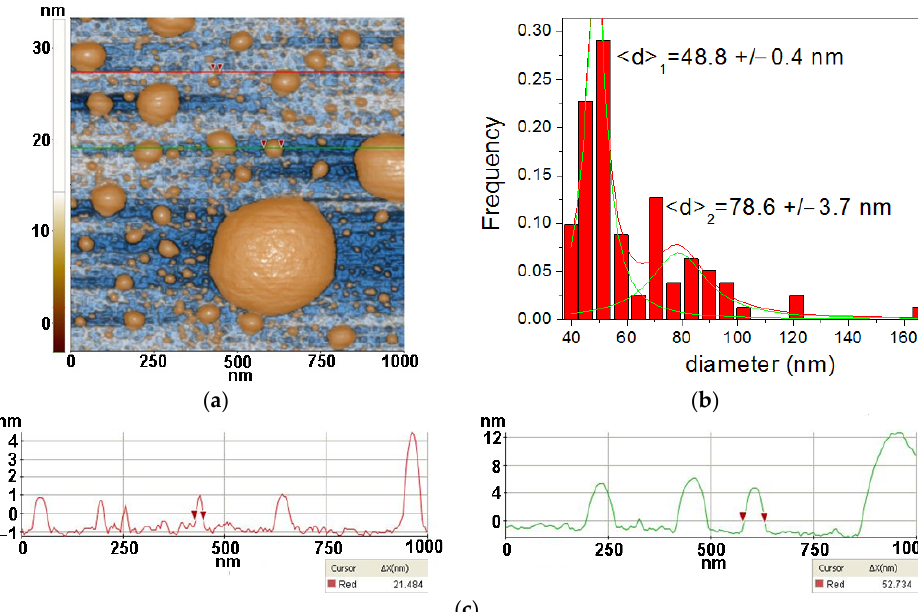
Figure 3. Two-dimensional AFM image scanned at a scale of (1 μ m × 1 μ m) of TiO 2 deposited on bare Si substrate ( a ) together with a particles’ diameters histogram for the TiO 2 , fitted with two Gaussian distribution functions ( b ) and two characteristic surface profiles (red and green line scans) ( c ).